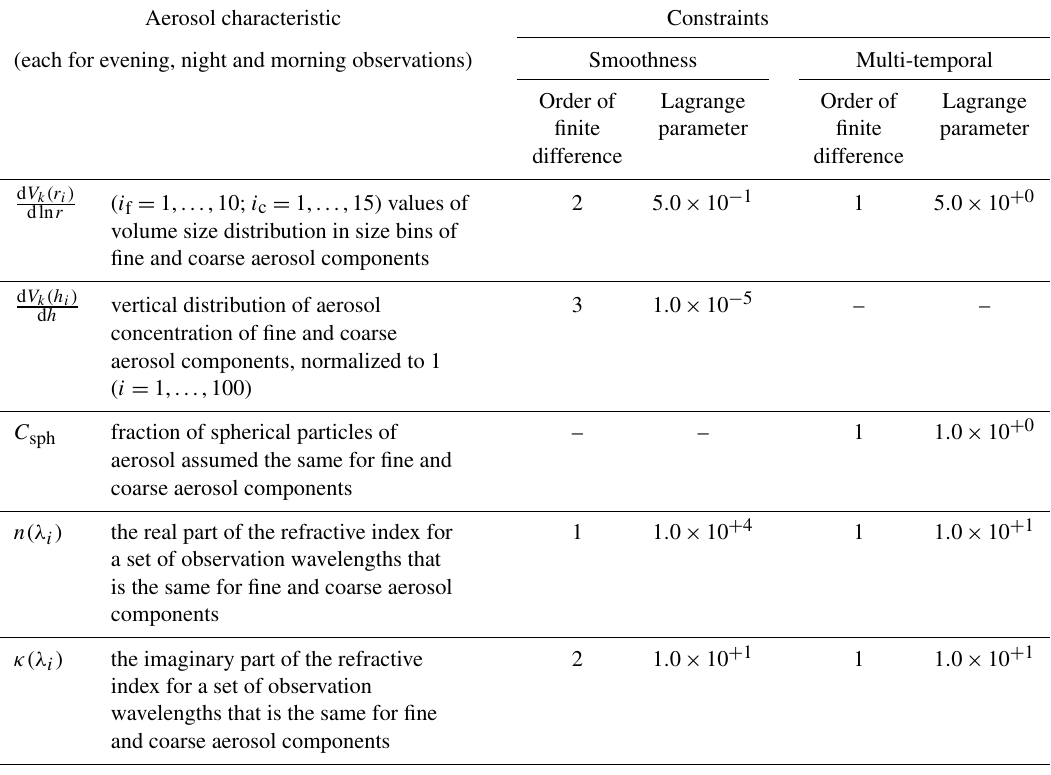
Table 1. Summary of the aerosol properties retrieved and provided by GRASP for each inverted time segment and the parameters of the applied constraints.